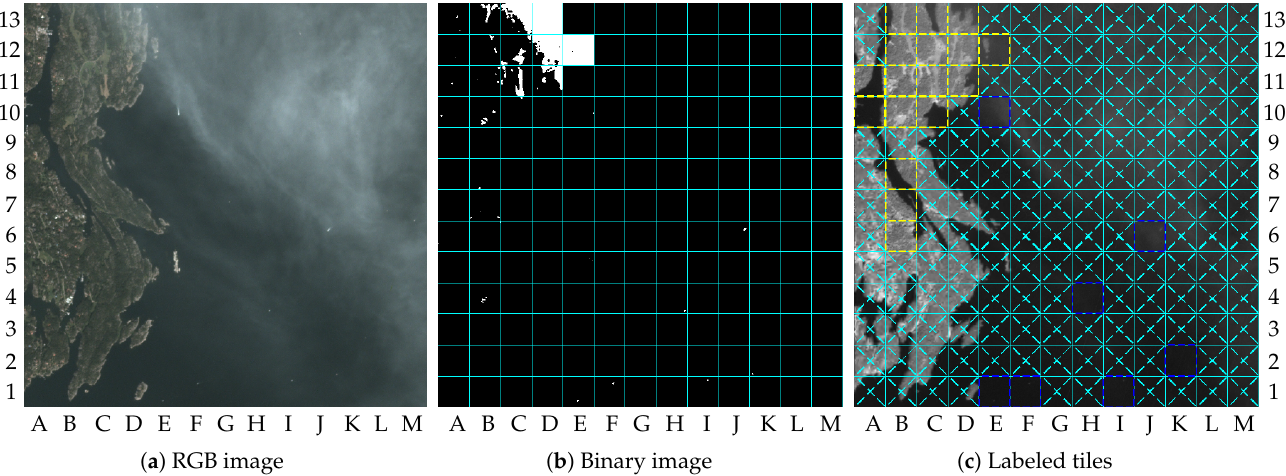
Figure 15. Results for image 18: ( a ) RGB image (truncated at 2000); ( b ) binary image; ( c ) labeled tiles (truncated at 4000).